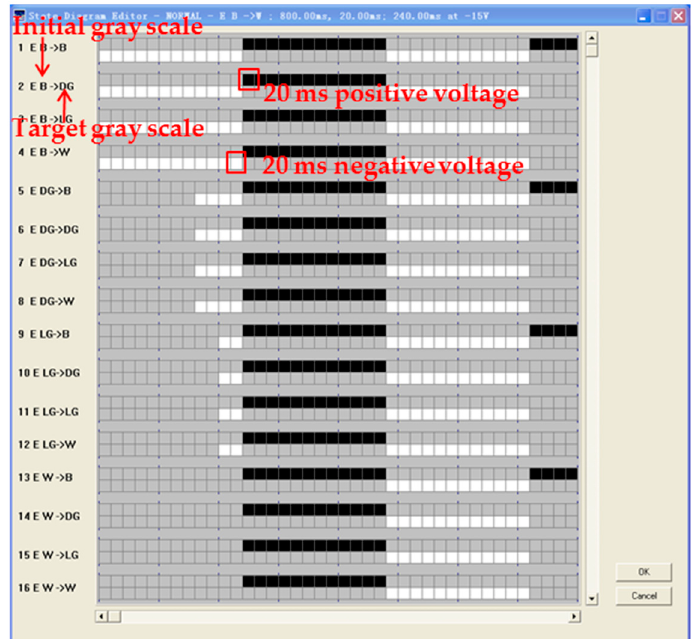
Figure 11. Waveform editing interface. A black grid indicates that a 20 ms positive voltage of +15 V is applied to the pixel electrode, a white grid indicates that a 20 ms negative voltage of − 15 V is applied to the pixel electrode, and the rest states are 0 V.